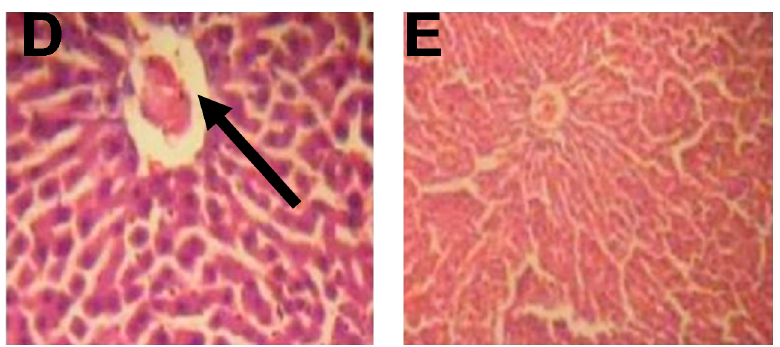
Figure 1. Histological examination of rat livers stained with hematoxylin and eosin (H&E). ( A ) Control: showing normal hepatic architecture with no lesions or abnormalities; ( B ) CCl 4 : showing congestion in the central vein associated with the infiltration of inflammatory cells; ( C ) T 1 : showing mild hepatocytes necrosis and mononuclear cellular infiltration; ( D ) T 2 : showing mild portal tract and lobular chronic inflammation with focal hepatocyte destruction; ( E ) T 3 : showing that improved hepatic architecture, inflammatory cell infiltration, and hepatocytes necrosis were hardly detected (×400).